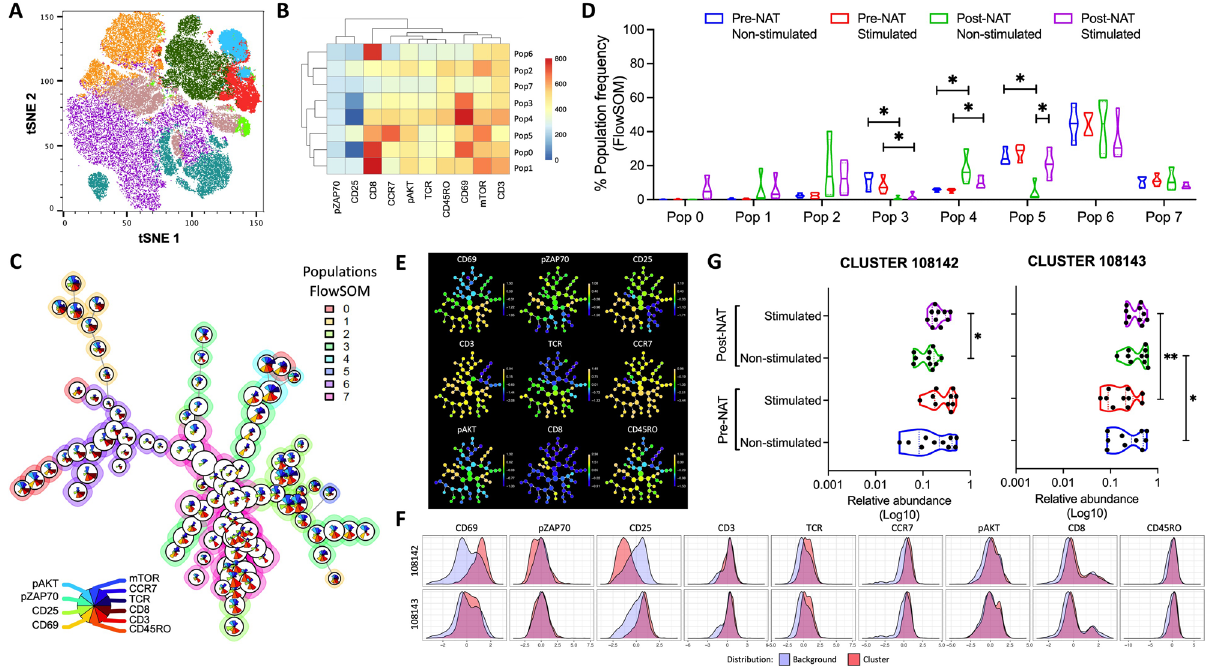
Figure 5. Response of PBMCs to in vitro stimulation of patients before and after NAT. ( A ) t-SNE plot for PBMCs with FlowSOM-based clusters. ( B ) Heat map indicating the expression level of different markers used in flow cytometry for each of the populations determined by FlowSOM grouped by their hierarchical proximity. ( C ) Spanning tree of the subpopulations determined by FlowSOM with the expression level of each marker within the circle (the size of the circle is proportional to the number of events). ( D ) Frequency of each FlowSOM subpopulation in the four groups of patient samples. ( E ) CITRUS-based expression tree for each of the markers in each subpopulation. ( F ) Histograms of expression of the clusters that differed statistically between the groups of samples. ( G ) Relative abundance (Log10) of the clusters that significantly differentiate the groups of patient samples. * p < 0.05, ** p <